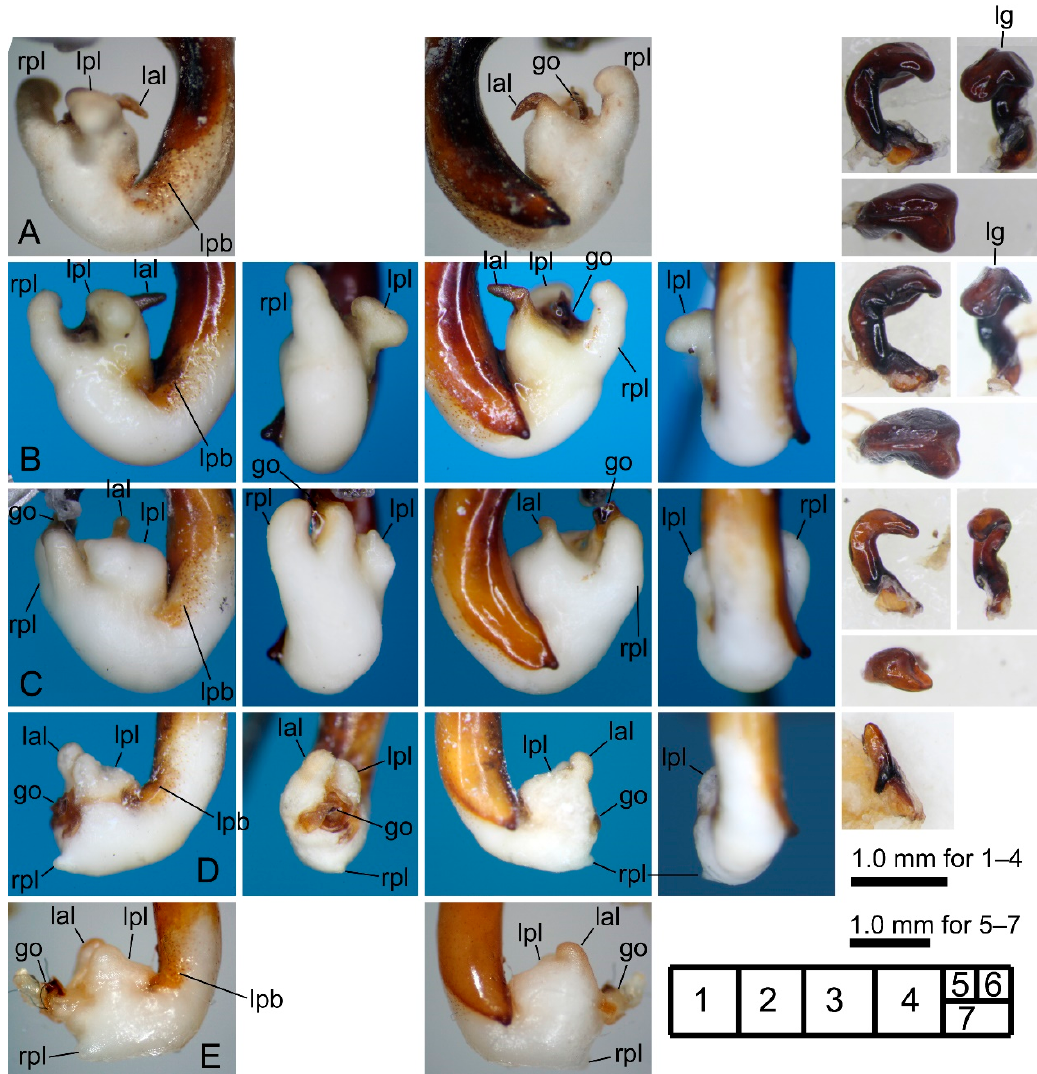
Figure 5. Left lateral ( 1 ), ventral ( 2 ), right lateral ( 3 ), and dorsal ( 4 ) views of aedeagus (part) with the everted endophallus and left lateral ( 5 ), apical ( 6 ), and dorsal ( 7 ) views of right paramere of the macrogenys species group; ( A ), ( B ) P. falcispinus males from type locality ( A1, 3 holotype male from “Cave Ishikiri”, A5 – 7 a non-type male from Mt. Ishikiriyama) and Mt. Takadateyama ( B ), ( C ) P. takadateyamanus male from Mt. Takadateyama, ( D ), ( E ) P. adatarasanus male from Mt. Takadateyama ( D ) and holotype male from “Tsuchiyu-Pass” ( E ).